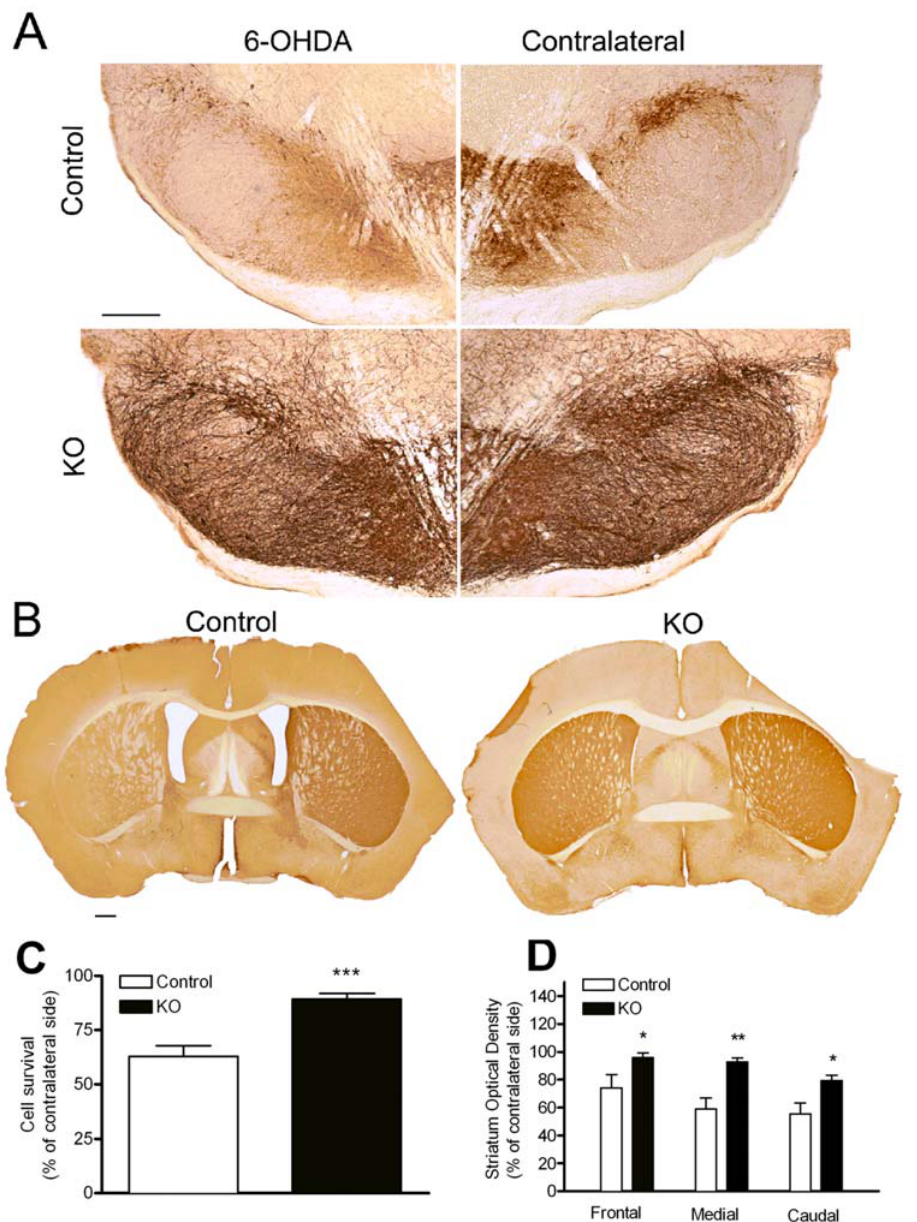
Figure 8. Pten ablation shows neuroprotective effects in the intrastriatal 6OHDA mouse model. Animals were treated with a unilateral 6OHDA injection in the striatum, and perfused 4 weeks after the injection to analyze the effect of Pten ablation on the magnitude of the lesion. (A) The SNc from control animals (n=4) was markedly affected by the lesion as reflected by the significant loss of TH positive profiles in the ipsilateral side to the lesion as compared to the contralateral side. The dopaminergic neurons in Pten KO (n=6) animals were largely spared after the lesion when compared to control animals. (B) The neuroprotective effects related to Pten ablation were observed at the level of the striatal axonal projections as well. Depletion of TH positive terminals in the striatum was reduced across the striatum in control animals, while axon terminal degeneration was much lower in Pten KO animals. (C) Survival rates for TH-positive neurons were quantified by stereologic counts. The number of surviving neurons (presented as percent surviving neurons when compared to the side contralateral to the lesion) was significantly increased in Pten KO animals (n=6) when compared to controls (n=4). (D) Optical density measurement in the injected striatum revealed a nearly complete preservation of TH terminals in Pten KO animals. TH staining density was significantly lower in control 6OHDA-treated animals with the biggest difference observed in the medial portion of the striatum, in accordance with sterotaxic coordinated used for the lesion. (A) Scale bar, 250 m m and (B) 500 m m. All data are mean 6 SEM. *p , 0.05, Student’s